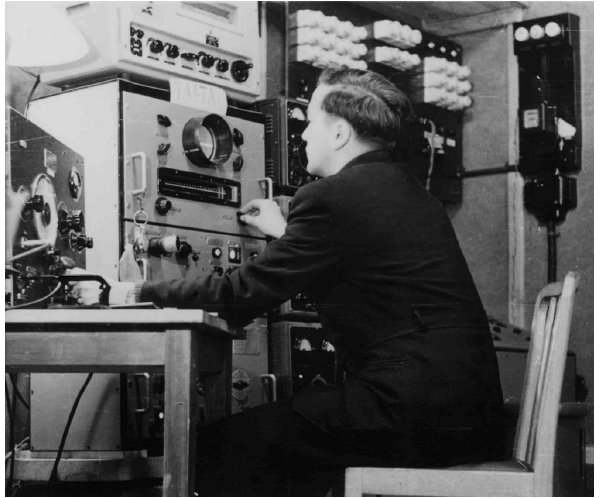
Figure 12. Operator at